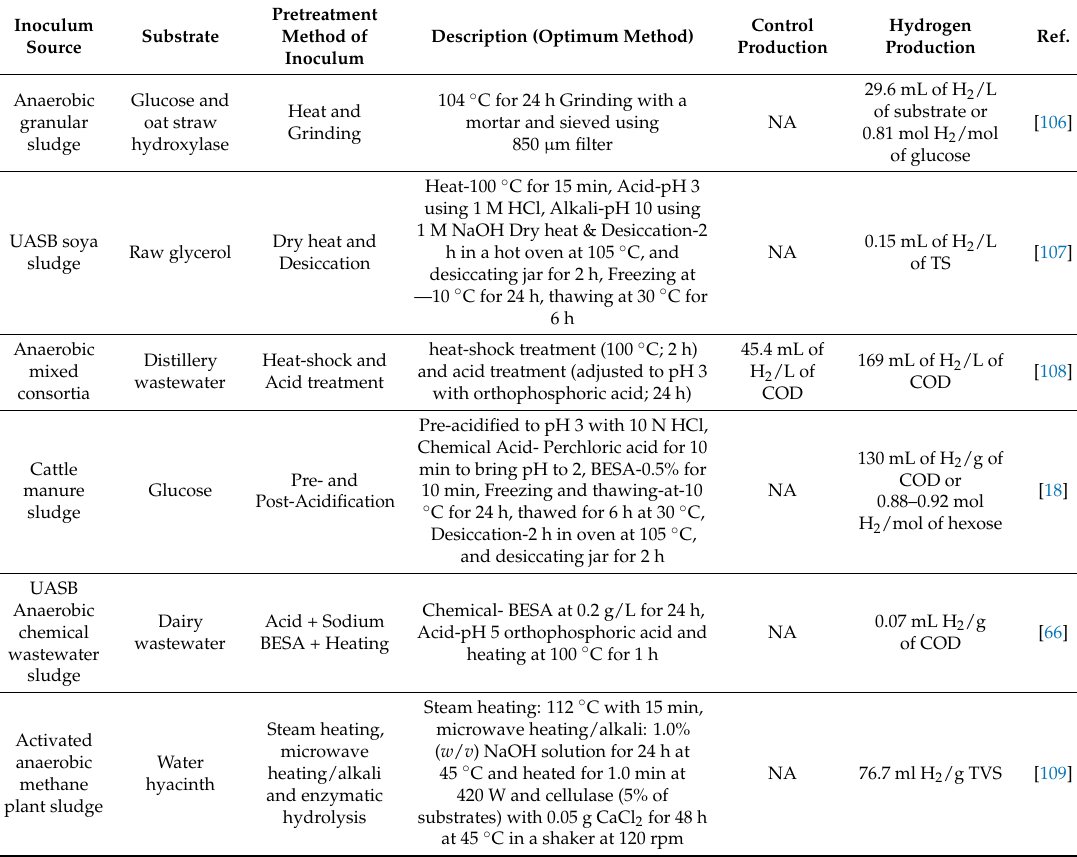
Table 5. Hydrogen yields produced by mixed cultures using combined